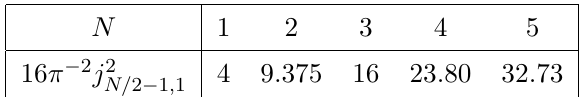
Table 1 . Approximate values of upper bounds on the ratios of the (cid:12)rst two nonzero eigenvalues of the scalar Laplacian on N -dimensional compact manifolds with nonnegative Ricci curvature. N 1 2 3